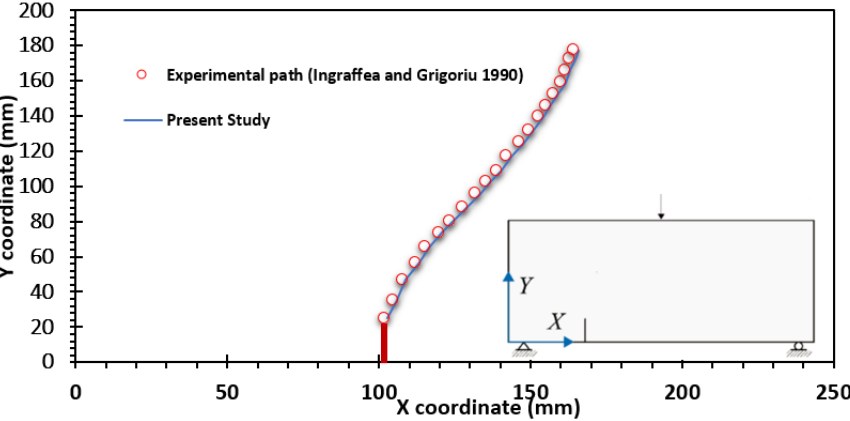
Figure 7. Predicted rack growth path for specimen 2.